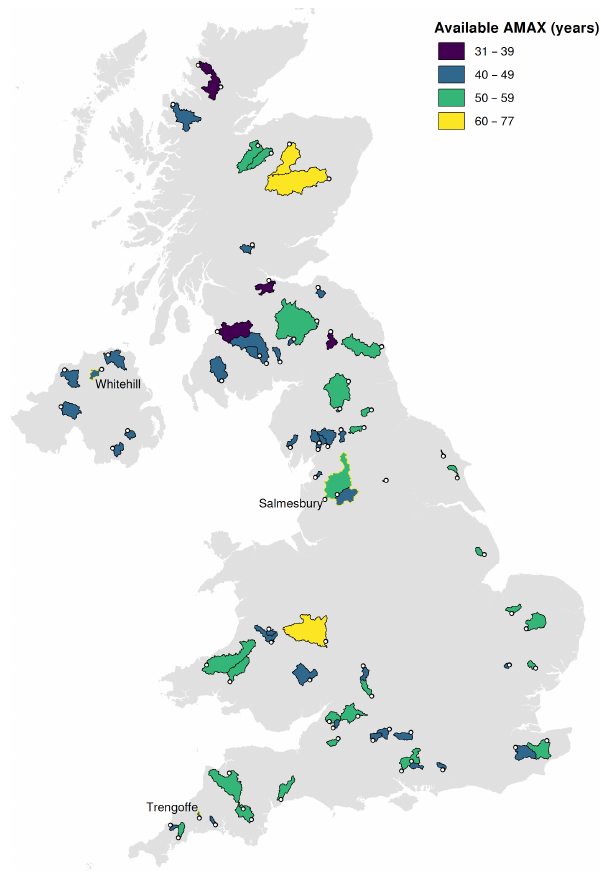
Figure 1. Locations of the 73 stations used in the analysis, high- lighting record length and location of associated watershed. The three stations considered individually in later figures are labelled and outlined in yellow.